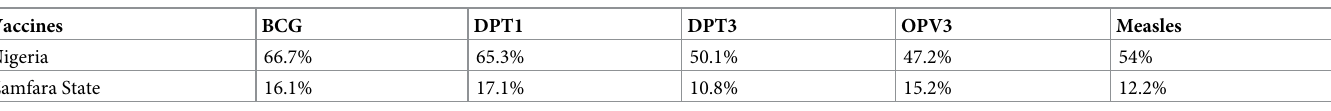
Table 1. Individual vaccine